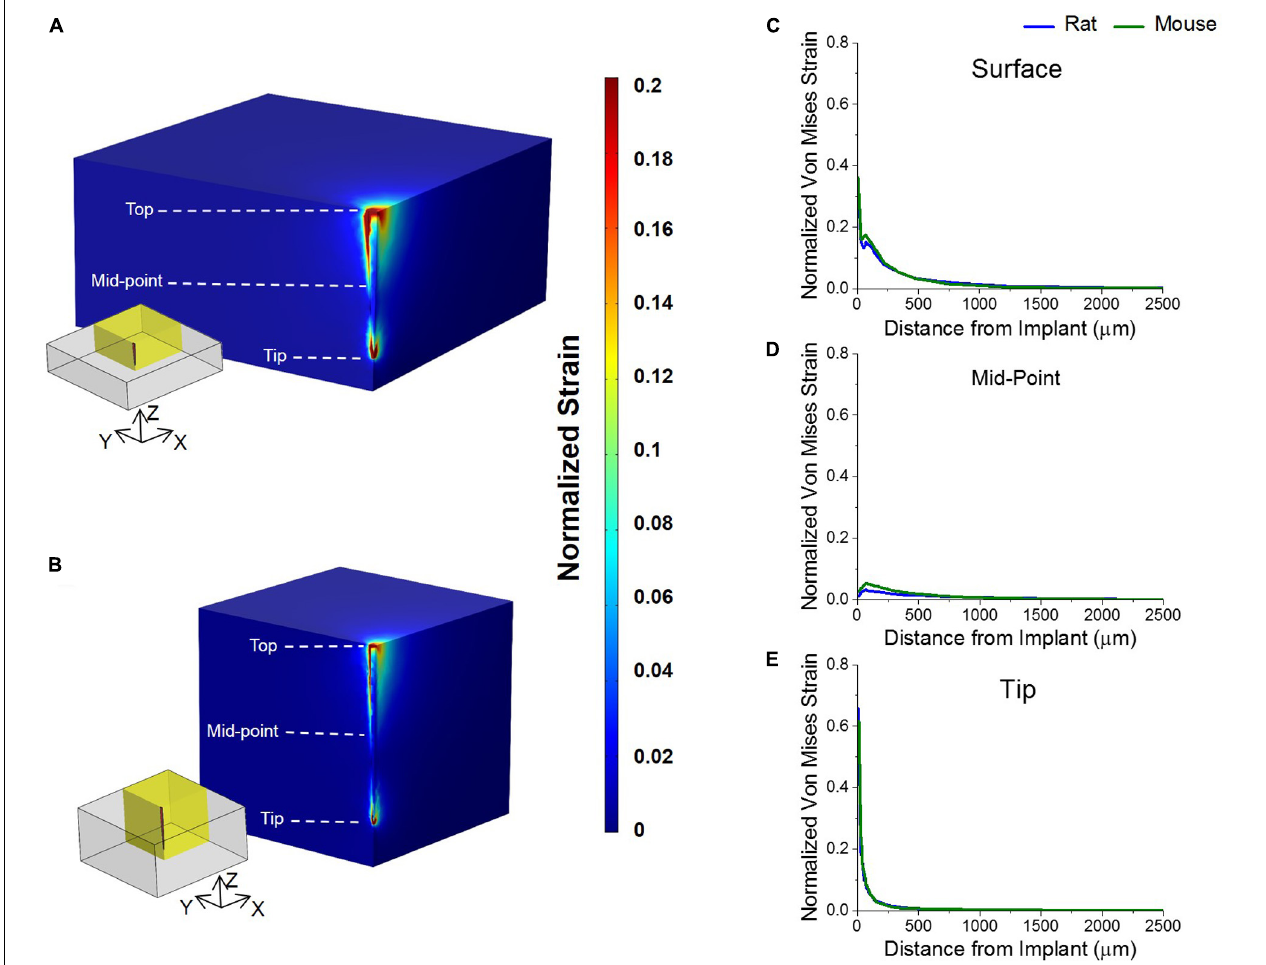
FIGURE 4 | Strain profiles of rat and mouse cortex from implanted silicon probes. Predicted strain profiles induced by a tangential tethering force on silicon probe implanted into (A) mouse and (B) rat cortex. Normalized strain among a quarter region of each model (as highlighted by yellow insets) were shown are shown. (C) The strain of the tissue surrounding the top of the electrode was predicted to be the highest in both animal models. (D) The strain around the mid-point of the probe was predicted to be negligible and close to zero in both animal models. (E) The strain surrounding the tip of the implanted probe was predicted to be lower than the strain at the top in both animal models. The strain between the two animals was predicted to be similar to each other at all three points